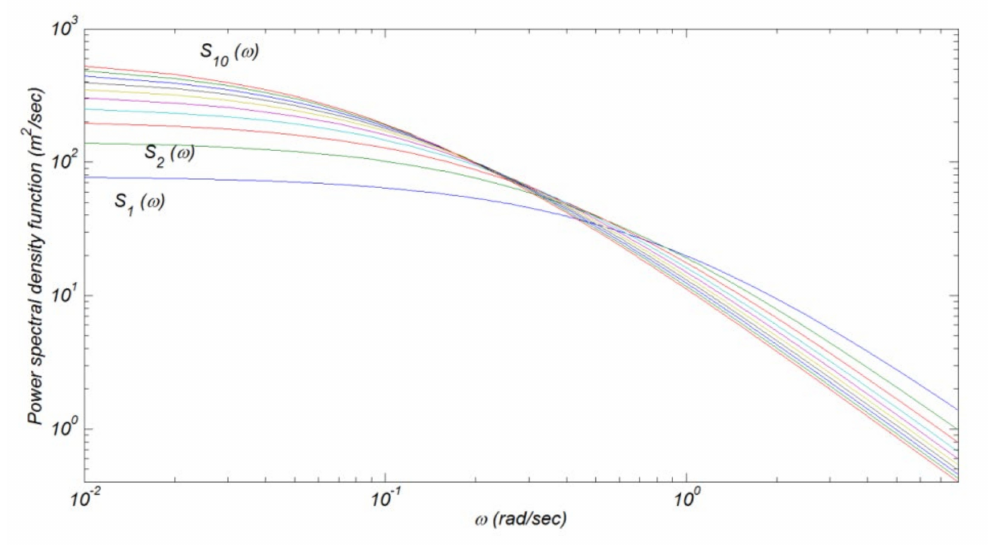
Figure 11. Kaimal spectrum at varying